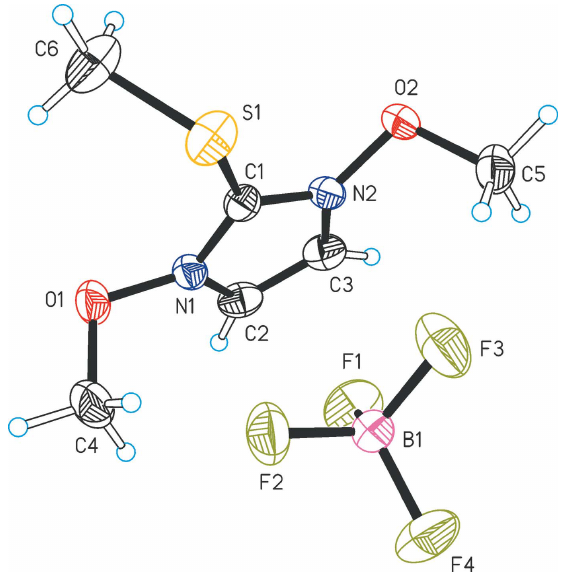
Figure 1 The ion pair structure of methylsulfanyl salt 1 , showing displacement ellipsoids drawn at the 50% probability level and hydrogen atoms drawn as spheres of arbitrary size.